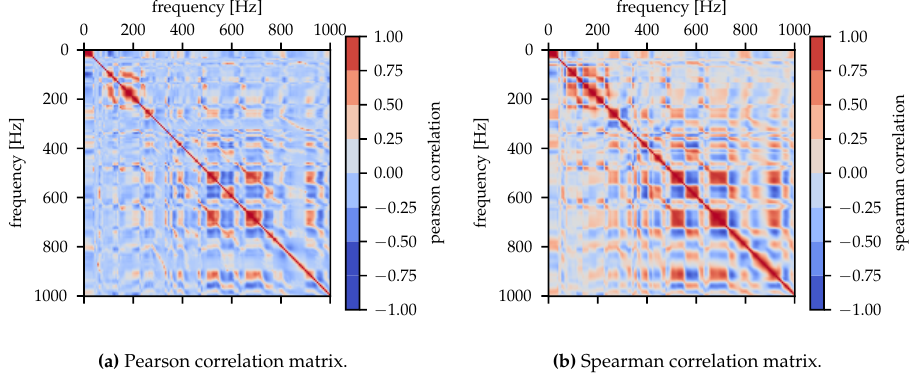
Figure 4. Correlation matrices for 5000 frequencies from the spectrum. Figure ( a ) shows the Pearson correlation matrix for linear dependencies and ( b ) the Spearman correlation matrix for nonlinear